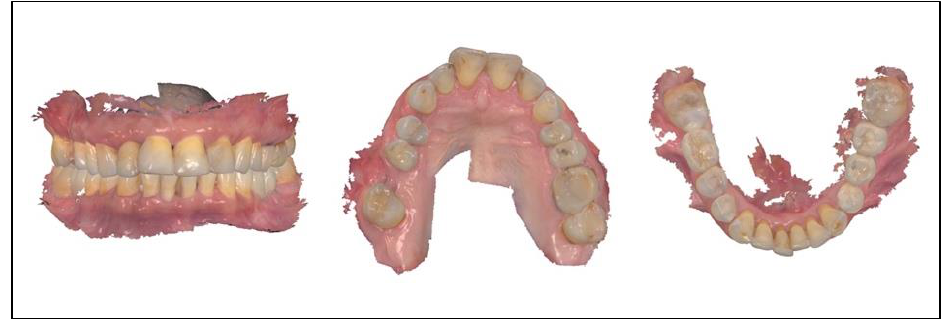
Figure 13. Scan of the initial situation .